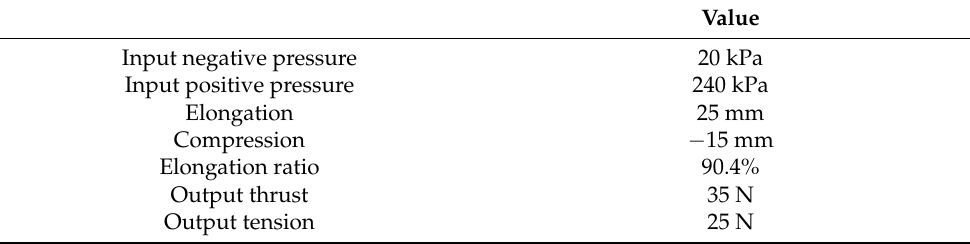
Table 2 lists all the maximum input and output parameters of the GBBA measured in these linear